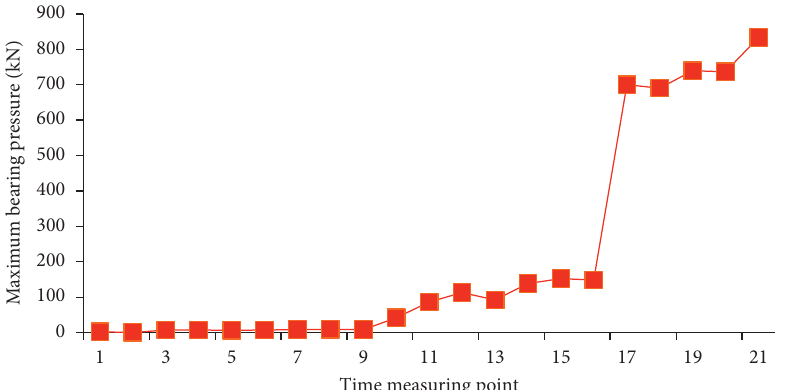
Figure 23: Stress curve of the 14th measuring point on the immediate